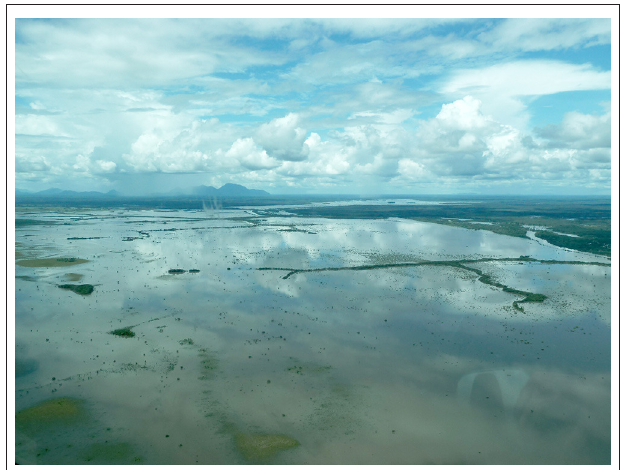
FIGURE 7 | North Rupununi savanna and wetlands during the rainy season with the Kanuku Mountains in the distance. Photo by: E. Paemelaere.